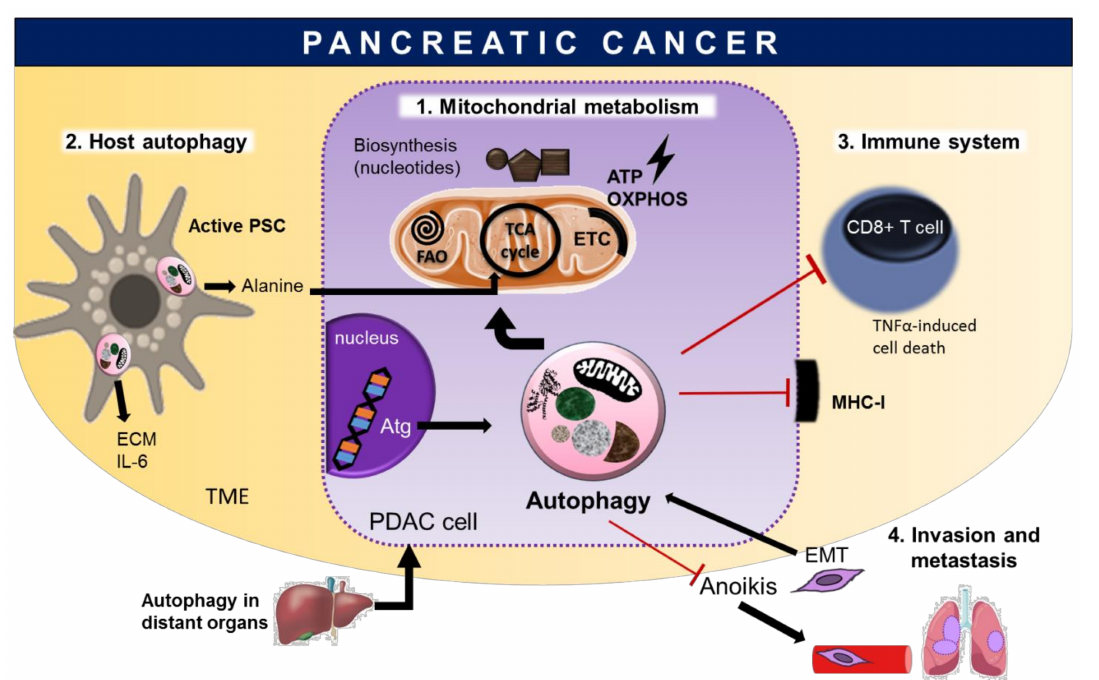
Figure 3. Autophagy supports Pancreatic Ductal Adenocarcinoma (PDAC) progression at late steps of tumorigenesis. PDAC cells exhibit high autophagy even under basal conditions and some elements are key to understand how autophagy sustains established pancreatic tumors. 1. Mitochondrial metabolism. Autophagy is necessary for a proper mitochondrial function, in particular for